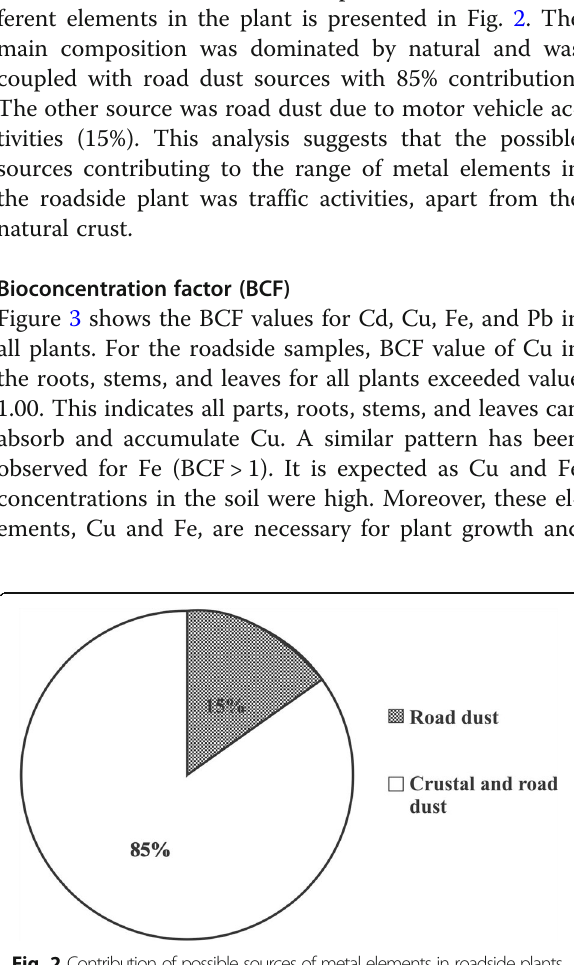
Fig. 2 Contribution of possible sources of metal elements in roadside